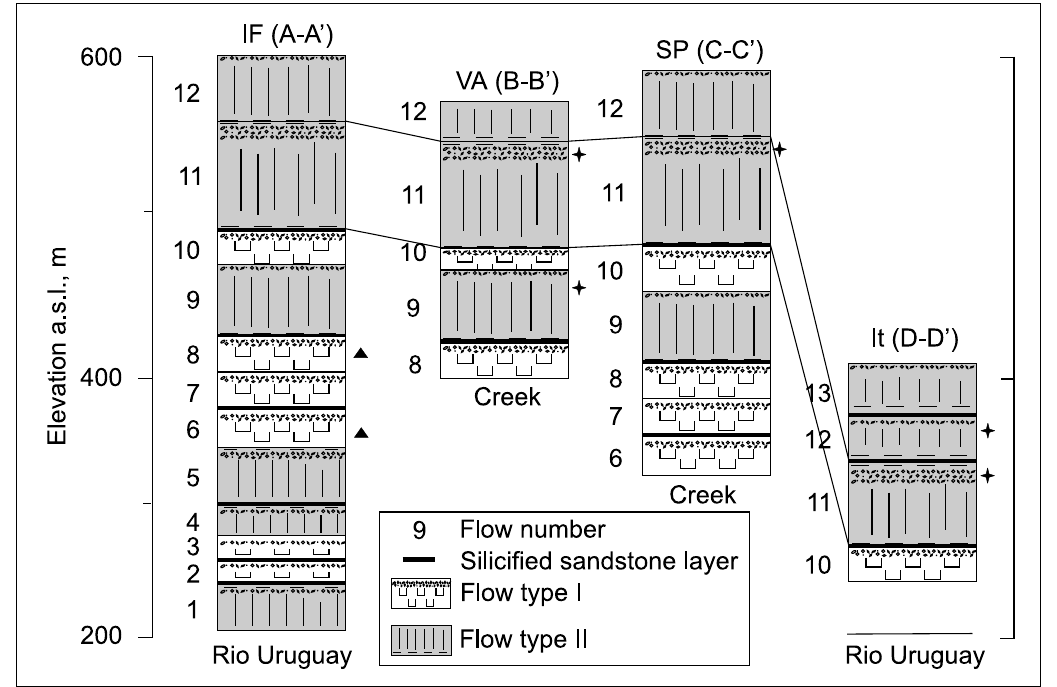
Fig. 3 – Correlation of four stratigraphic sections in the Vista Alegre region. Dark triangles indicate amethyst-bearing geode occurrence (after Gomes 1996) and dark stars the copper occurrences (this work). Nearly 200 m down-drop of Itapiranga section is indicated. IF = Iraí-Frederico